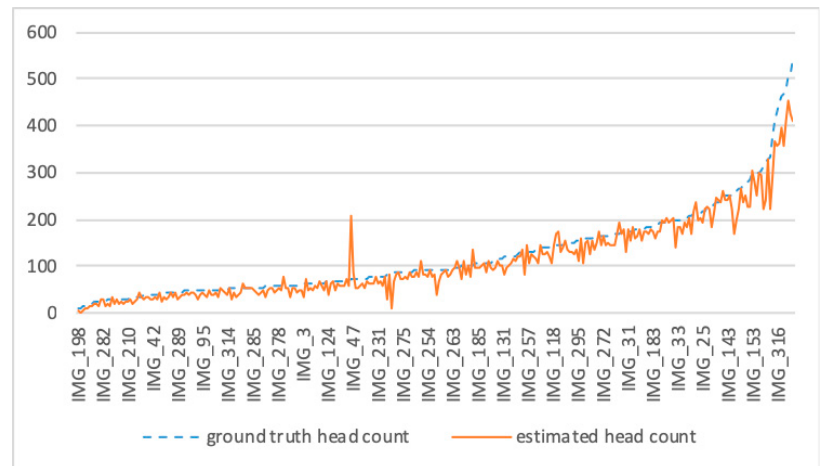
Figure 5. The ground truth head count and estimated head count with FF-CNN on Part B dataset (the vertical axis represents the head counts, and the horizontal axis represents the test sample).